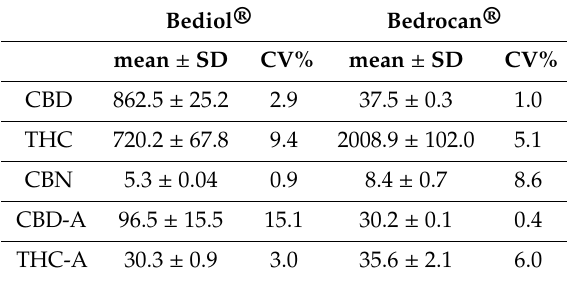
Table 3. Coefficient of variation (CV%) in the concentration of cannabinoids at T0 (ppm) in Bediol ® ( n = 2) and Bedrocan ® oils ( n = 2) between the lipid sources considered.